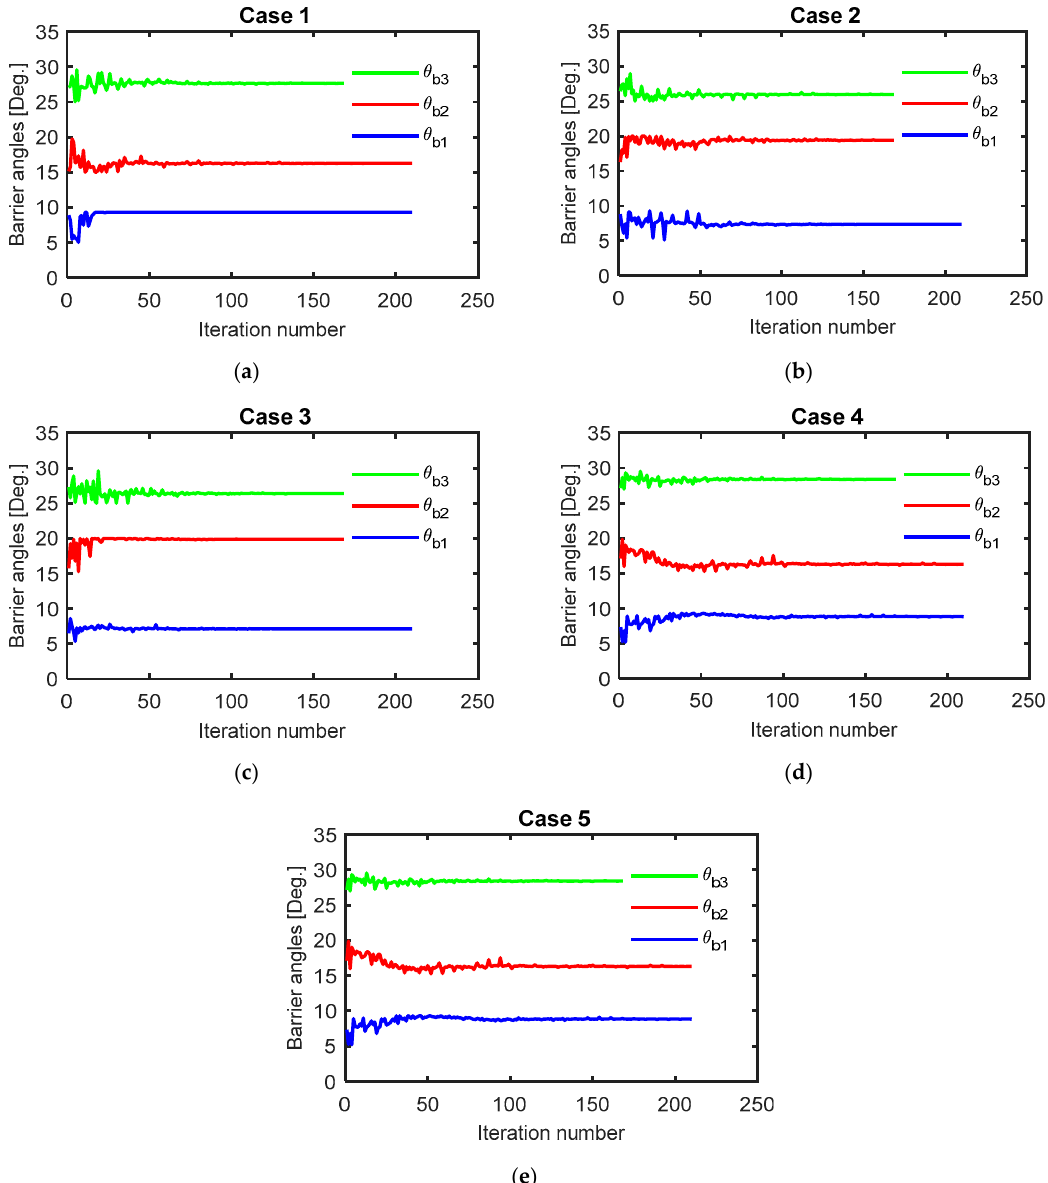
Figure 7. Optimal geometry of flux barrier angles for different cases, ( a ) case 1, ( b ) case 2, ( c ) case 3, ( d ) case 4 and ( e ) case